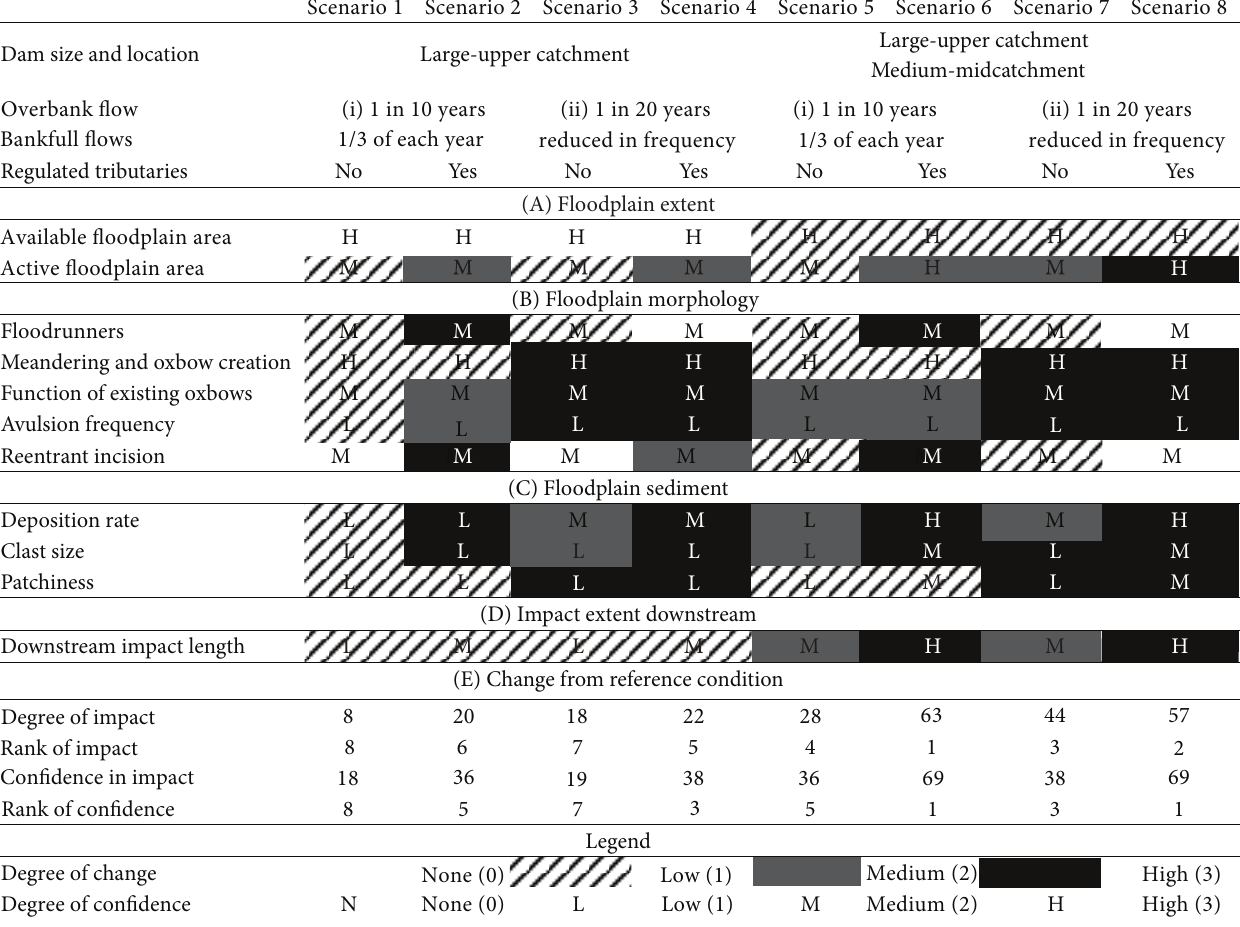
Table 3: Floodplain alterations from reference condition based on eight scenarios with the following variables: (1) 1 upstream dam; (2) 1 upstream and one midcatchment dam; (3) irrigation flows; (4) water supply flows; (5) dammed tributaries; (6) undammed tributaries. (A) The available floodplain area may be reduced by reservoir inundation, whilst the active floodplain will be reduced by lowering the area of flood extent. (B) Morphology may be altered by changes in the equilibrium between deposition and erosion. (C) The sedimentology may vary in rate, size, and also patchiness (or homogeneity) in both the cross and longitudinal profile of the floodplain. (D) The impact length downstream is used as a multiplier for (E) to weight the sum of A + B + C and then ranked from 1 (highest) to 8 (lowest) to denote modification from reference. The degree of confidence of each impact is rated None, Low, Medium, and High, based on the scientific understanding of the processes involved and also the cumulative impact of multiple dams, on both the main-stem and